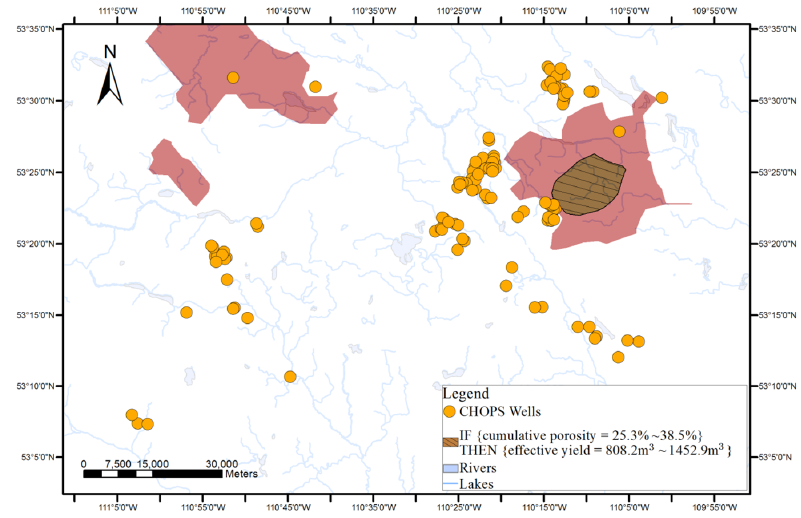
Figure 12. Prediction map generated by Surface-based geovisualization based on Kriging interpolation of IF {cumulative porosity = 25.3%–38.5%} THEN {effective yield = 808.2–1452.9 m 3 }.